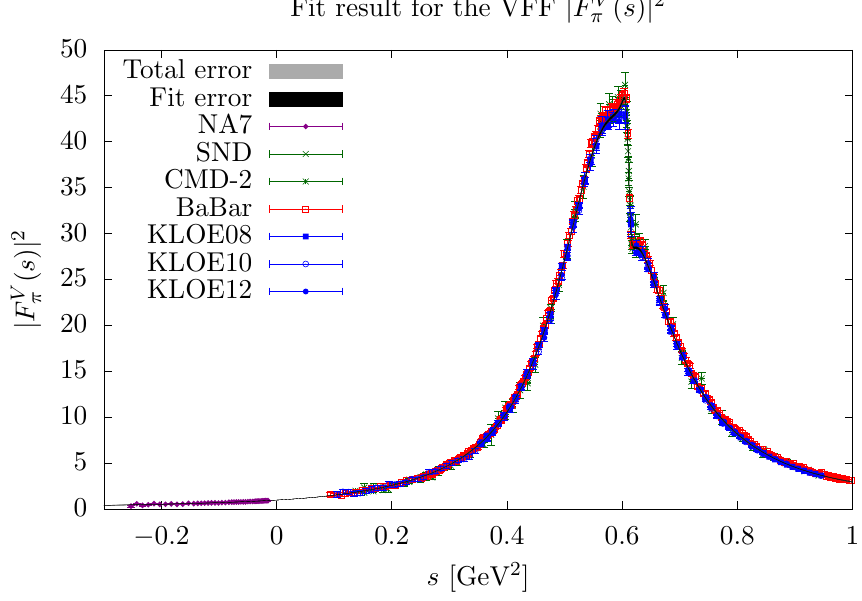
Figure 8. Fit result for the pion VFF j F V ( s ) j 2 including (barely visible) uncertainties, together (cid:25) with all the data sets used in the (cid:12)t. For the e + e (cid:0) experiments, the experimental values of the form factor are obtained from the published cross section according to section 2.1.